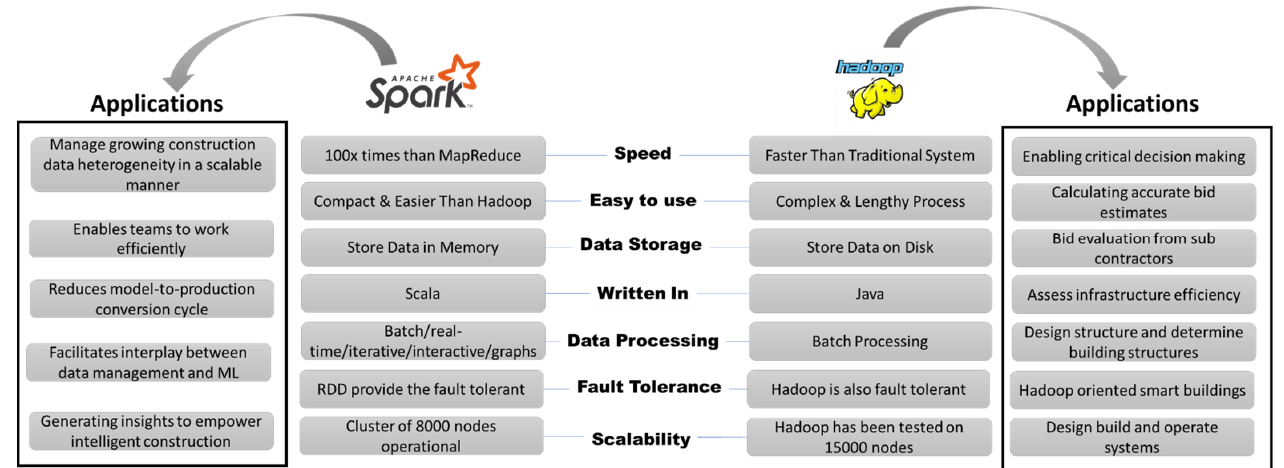
Figure 7. Components of Spark and Hadoop. A side-by-side comparison of Spark and Hadoop provides insights about the usability and applications of each.